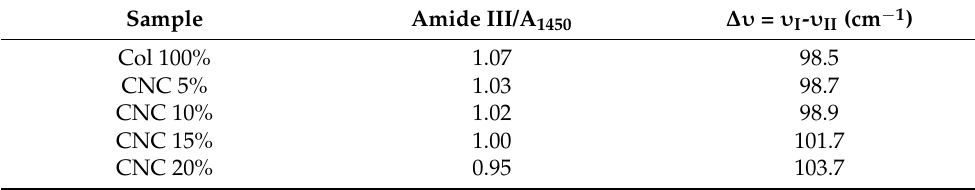
Figure 5. FTIR spectra of collagen and CNC/Col hydrogels. Table 2. FTIR characteristics of CNC/Col hydrogels.